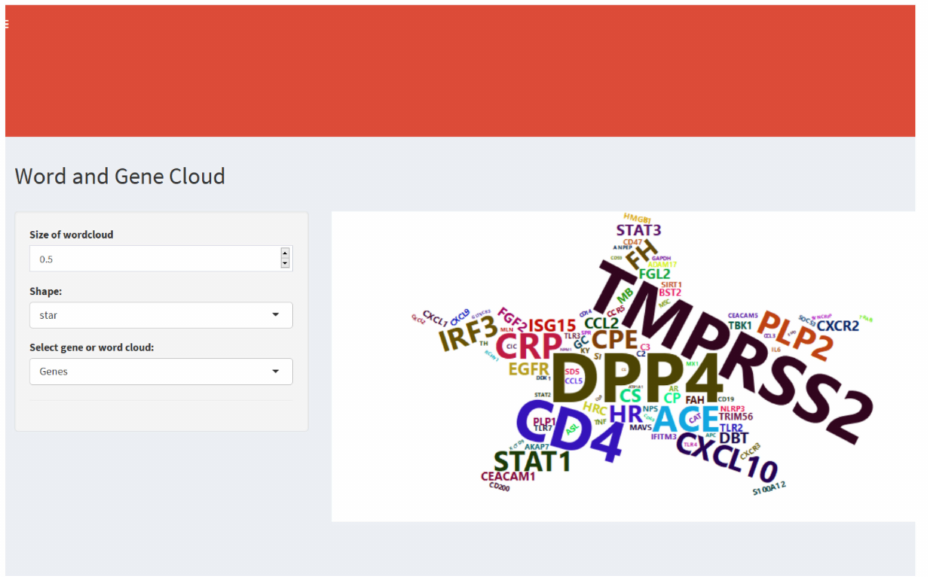
Figure 4. Menu and settings to generate the word cloud in different geometric figures. It is possible to select the option “Word” to generate the cloud of the most frequent words present in the abstracts of coronavirus papers. The “Genes” option shows the cloud of the most frequent genes present in the abstracts. The “Size of wordcloud” option refers to font size: the default is 0.2, and a larger size means bigger